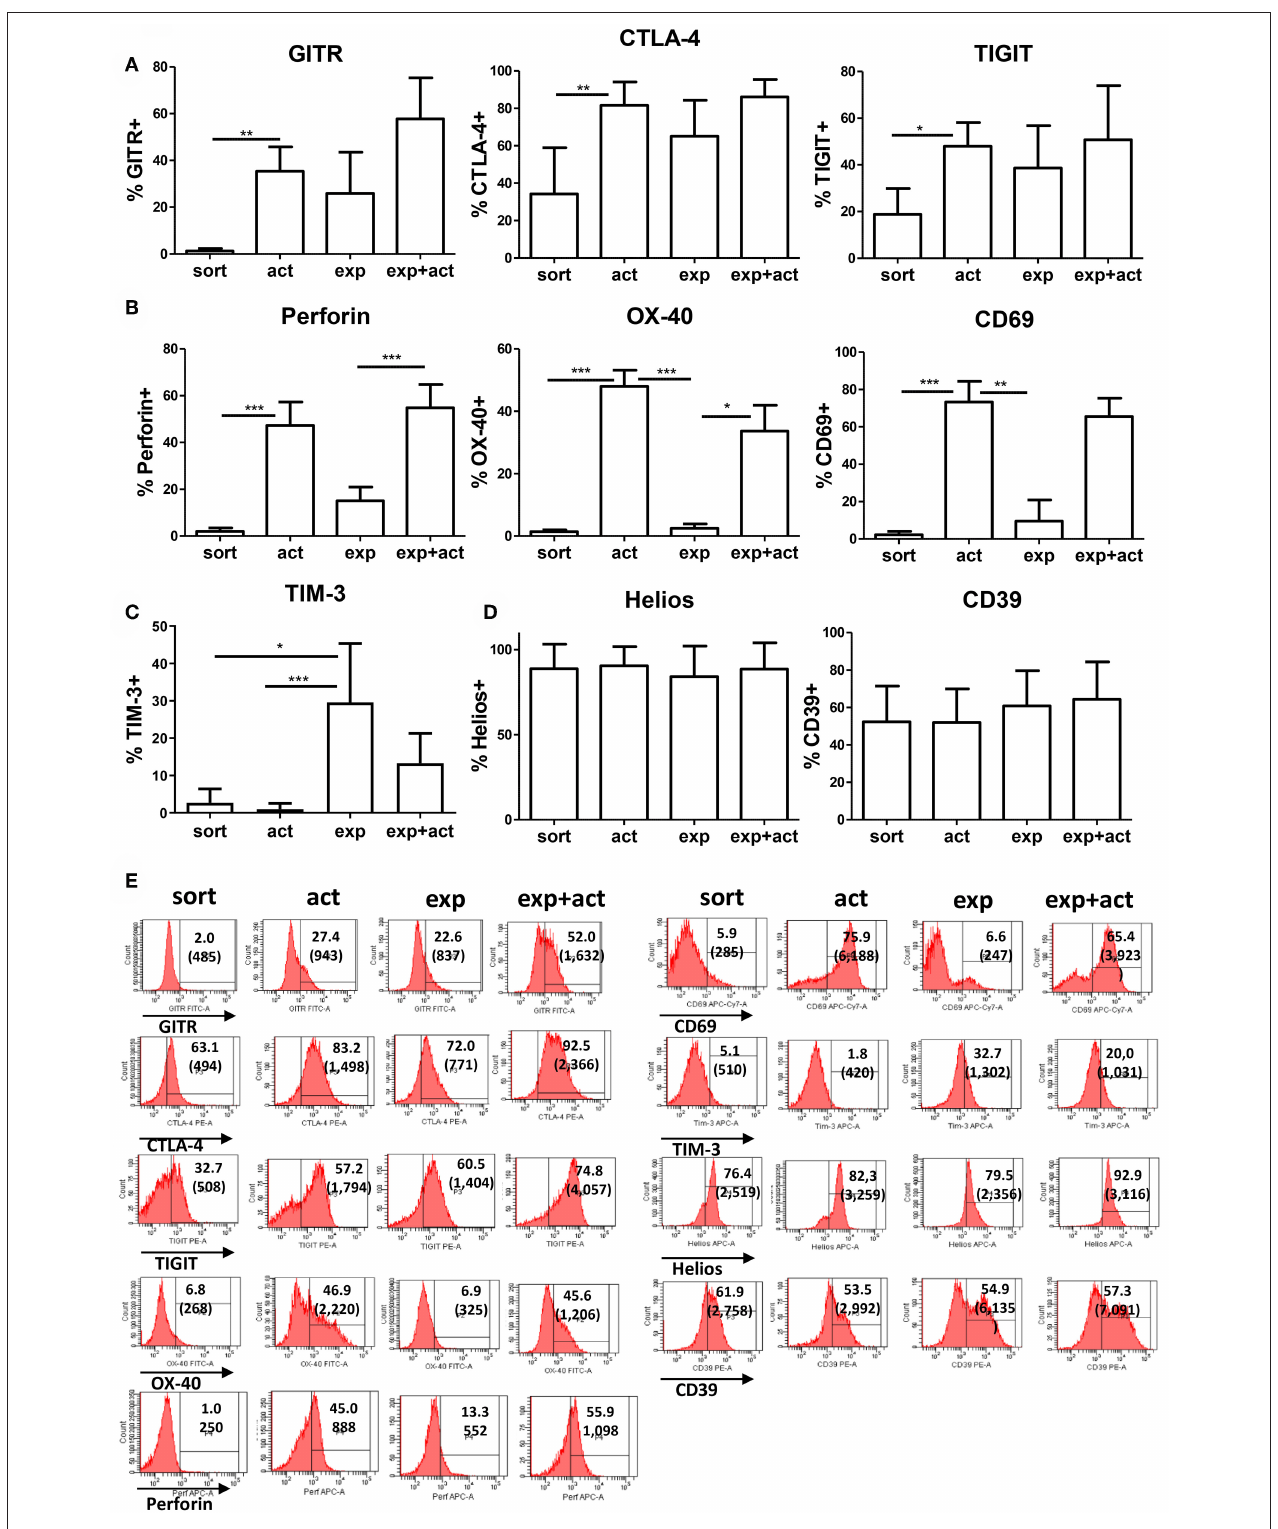
FIGURE 2 | Expression of Treg-associated markers. (A–D) Freshly isolated (sort), transiently activated (act), ex vivo expanded (exp) and transiently reactivated expanded (exp + act) human Tregs were stained for expression of Treg-associated markers. (E) Representative FACS plots of the Treg-associated markers shown in (A–D) . n = 4–7 separate donors. * p < 0.05 Error bars represent the means and standard deviations (SD). Groups were compared using a non-parametric Kruskal-Wallis ANOVA with Dunn’s post-hoc multiple comparisons test. ** p < 0.01, *** p < 0.001.